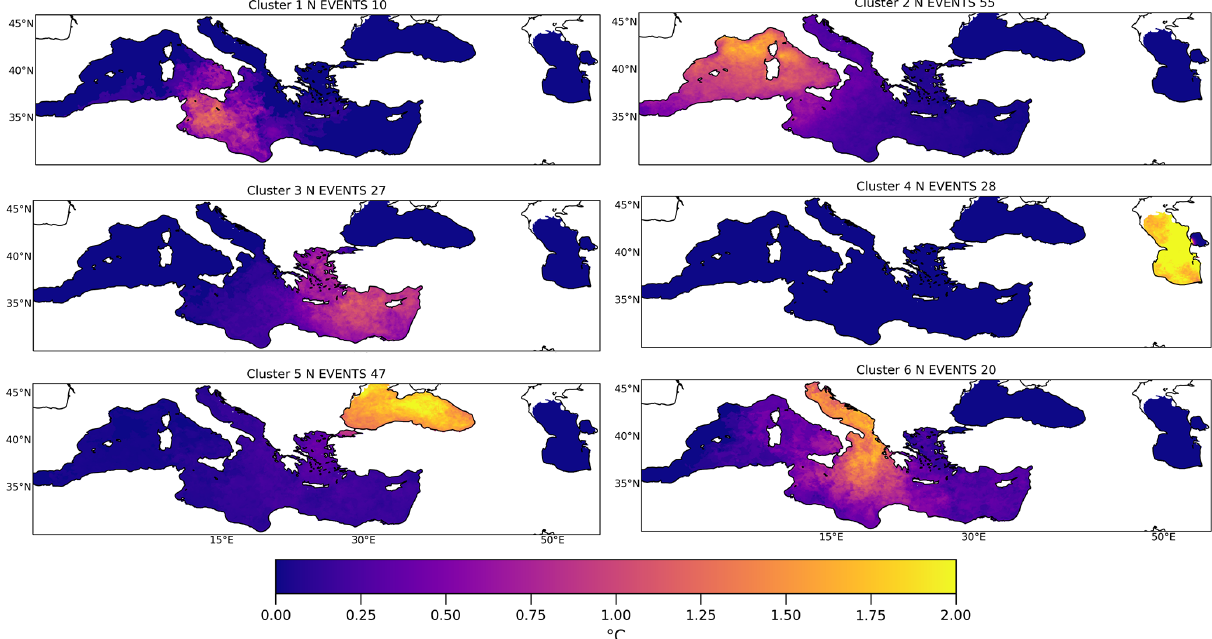
Figure 10. Patterns of the clusters represented by the average of the mean intensity of all the event maps of each cluster.